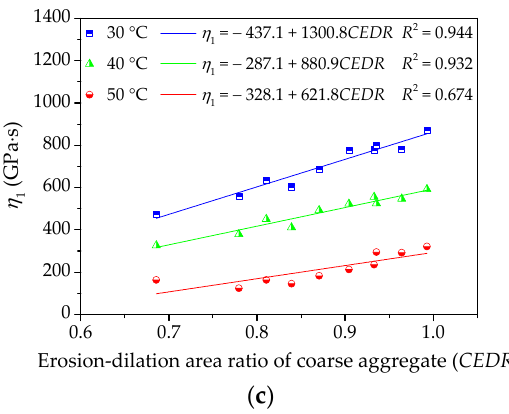
Figure 12. Influences of coarse aggregate morphological characteristics of on η 1 of asphalt mixture: ( a ) Shape ( CR ); ( b ) Angularity ( CPI ); and, ( c ) Texture ( CEDR ).